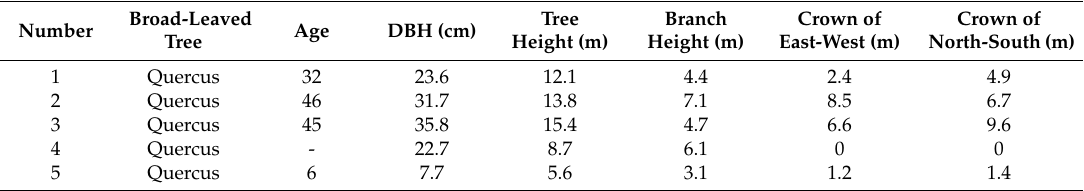
Table 6. Values of basic parameters of broad-leaved trees in plot 1.